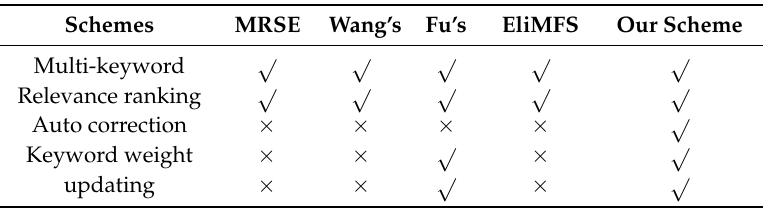
Table 3. Comparison of supported functions.